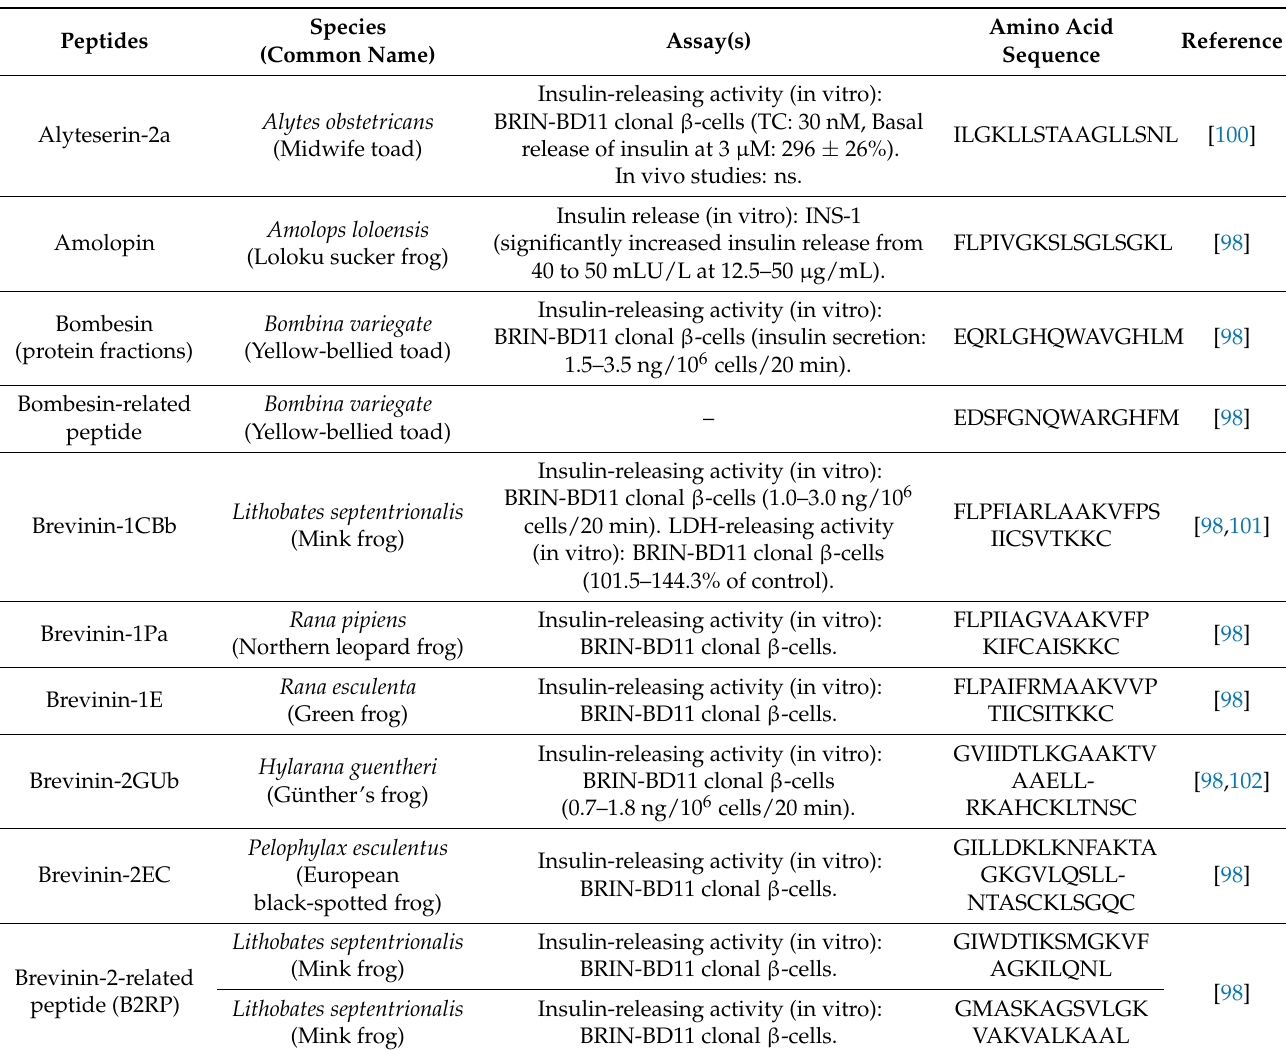
Figure 3. Mechanisms of action of antidiabetic peptides [98]. Table 5. Representative antidiabetic peptides (ADPs) isolated from various species of amphibians.